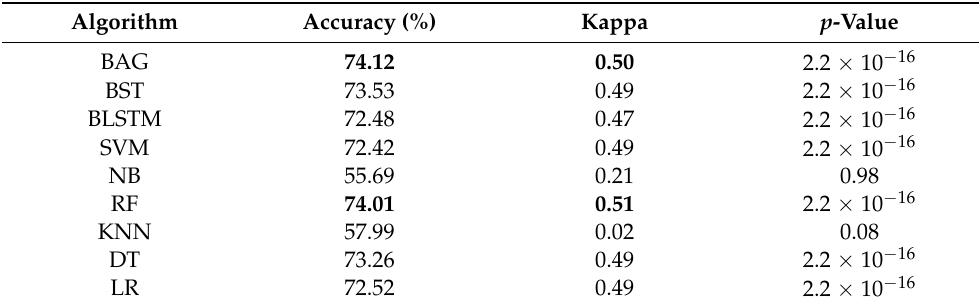
Table 7. Performance of BBNR on BAG, BST, BLSTM, SVM, NB, RF, KNN, DT, and LR. The best results are shown in bold.